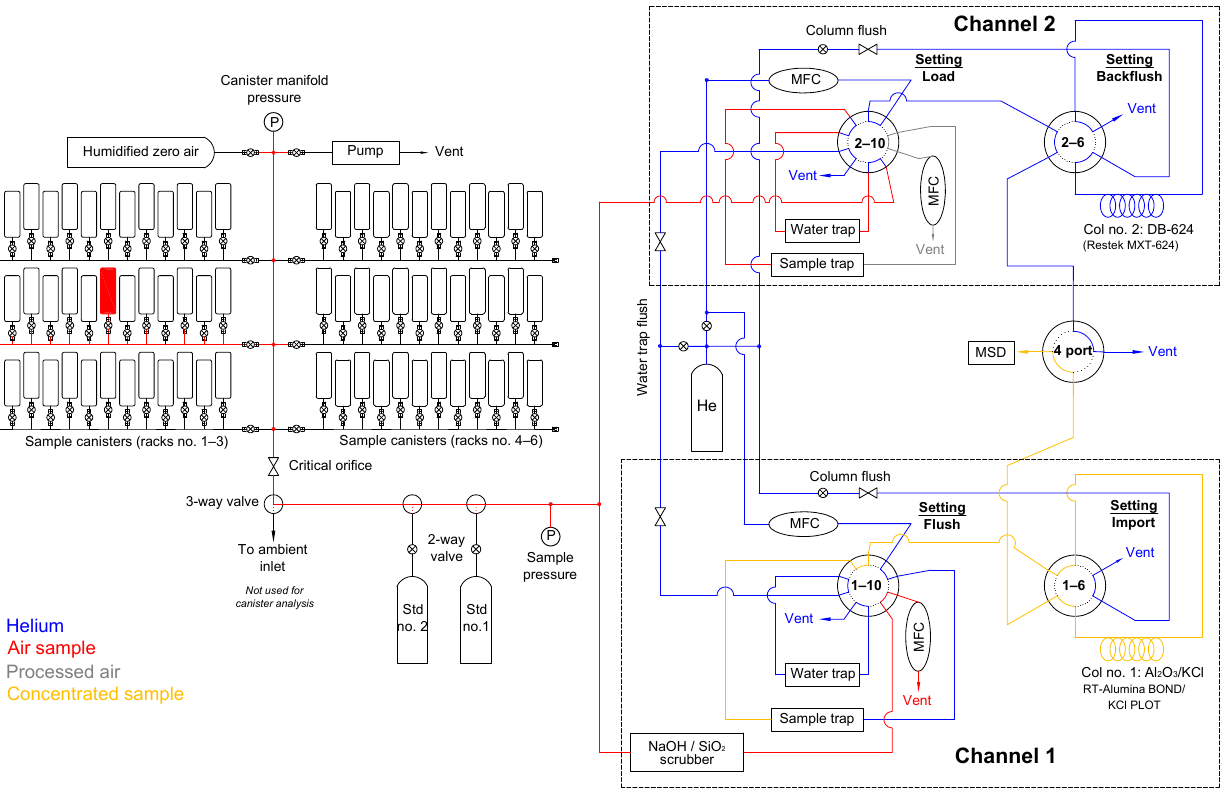
Figure 1. Schematic of instrument with flow path and valve position. Figure shown with open valve for a canister of middle-left sample module, Ch 1 flushing sample trap effluent to separation column, and Ch 2 loading sample